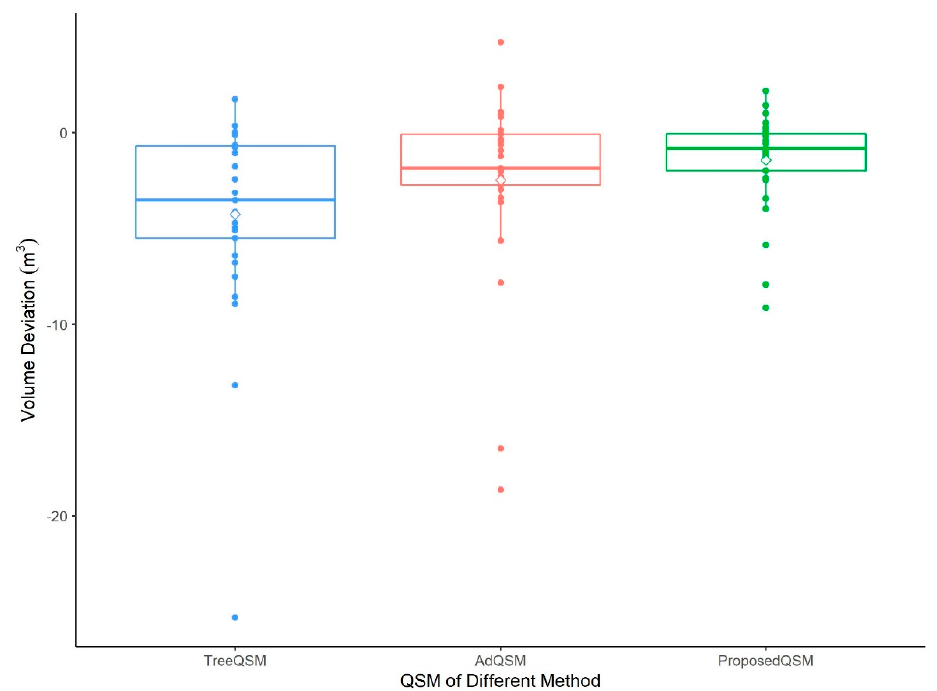
Figure 18. Volume deviations of the 29 samples for the three methods.